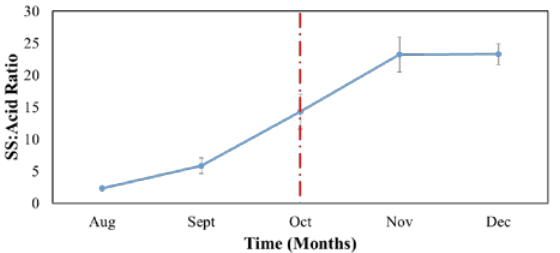
Figure 3. Ratio of soluble solid (SS)/acid content in juice during the growth and maturing stages. Each data point is the mean ± S.D. of five replications.